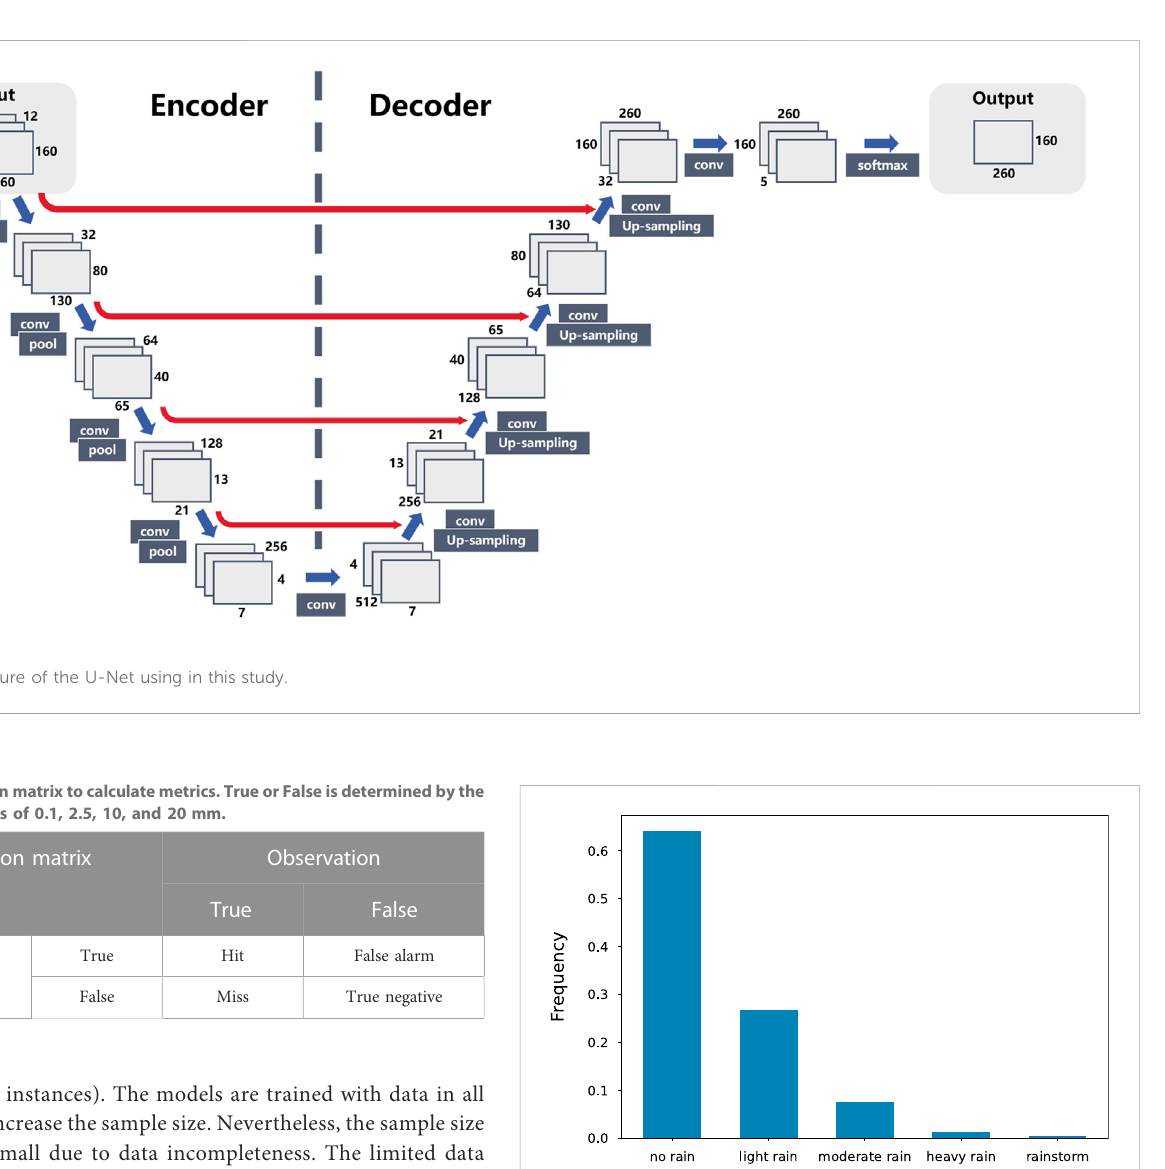
FIGURE 2 The occurrence of each precipitation level in the